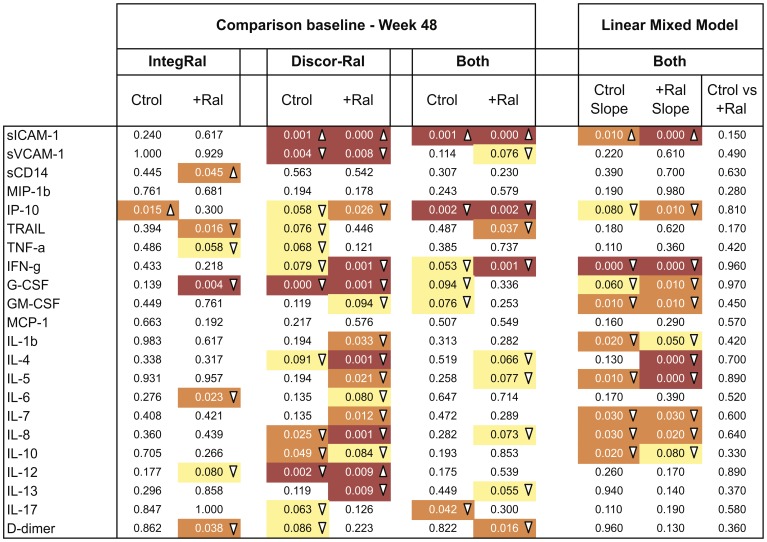
Longitudinal analysis of soluble plasma markers.Left part shows the heat map of the p-values obtained by comparing the levels of plasma soluble markers at baseline and week 48 in the IntegRal and Discor-Ral studies or in a global analysis of both studies. P-values are given for the control (Ctrol) and intensified (+ Ral) groups as indicated. Right part shows the results from a linear mixed model analysis showing p-values for slope (change of every marker per week) for control and intensified groups and the interaction slope/group that indicates the existence of significant difference among groups. As in Figure 2, color codes are as follow: no color means p-value>0.1, yellow 0.1>p-value>0.05; orange 0.05>p-value>0.01 and red p-value<0.01. Upward arrowheads (Δ) indicate positive correlations while downward arrowheads indicate negative correlations.